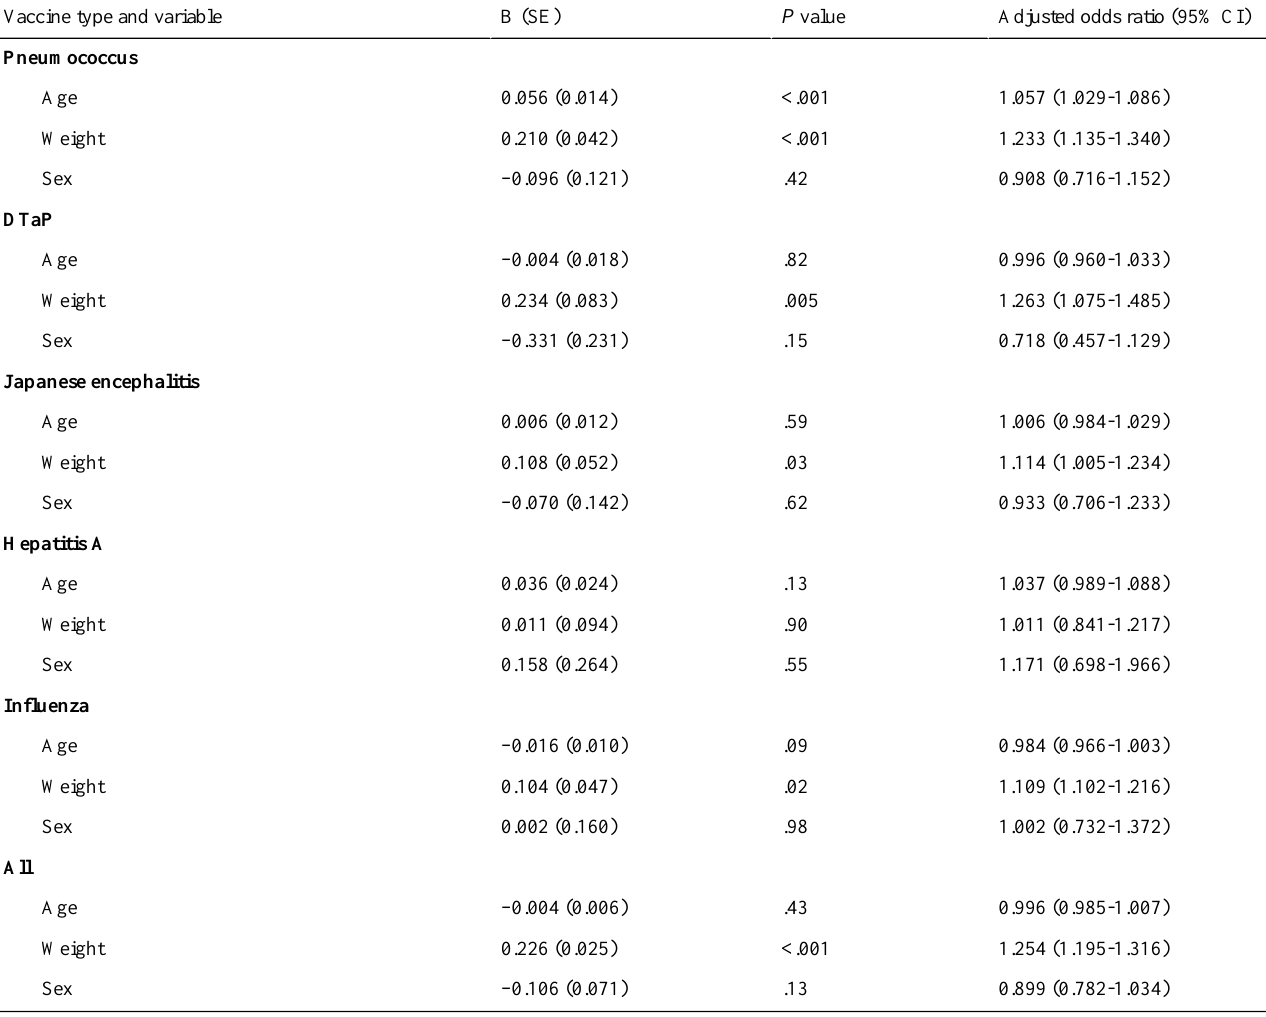
Table 3. Variables involved in relatively high postvaccination fever ( ≥ 39°C).